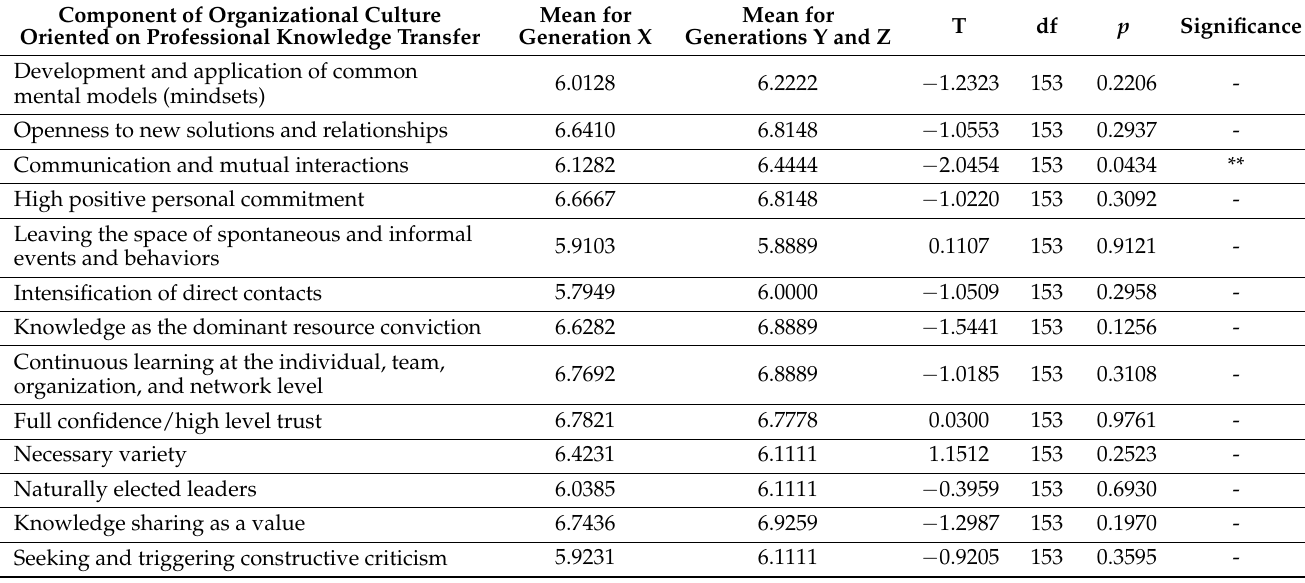
Table 6. T -test for variables of organizational culture oriented on professional knowledge exchange between IT knowledge workers within organization in terms of generations.